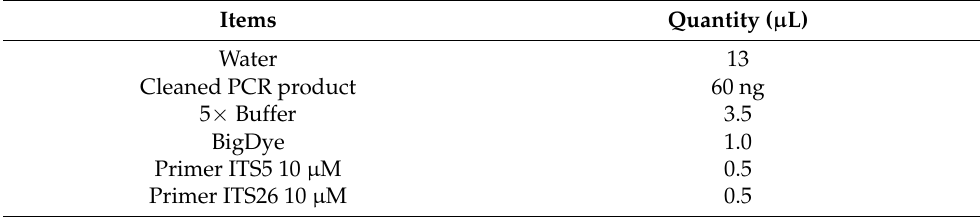
Table 7. Sequencing reaction